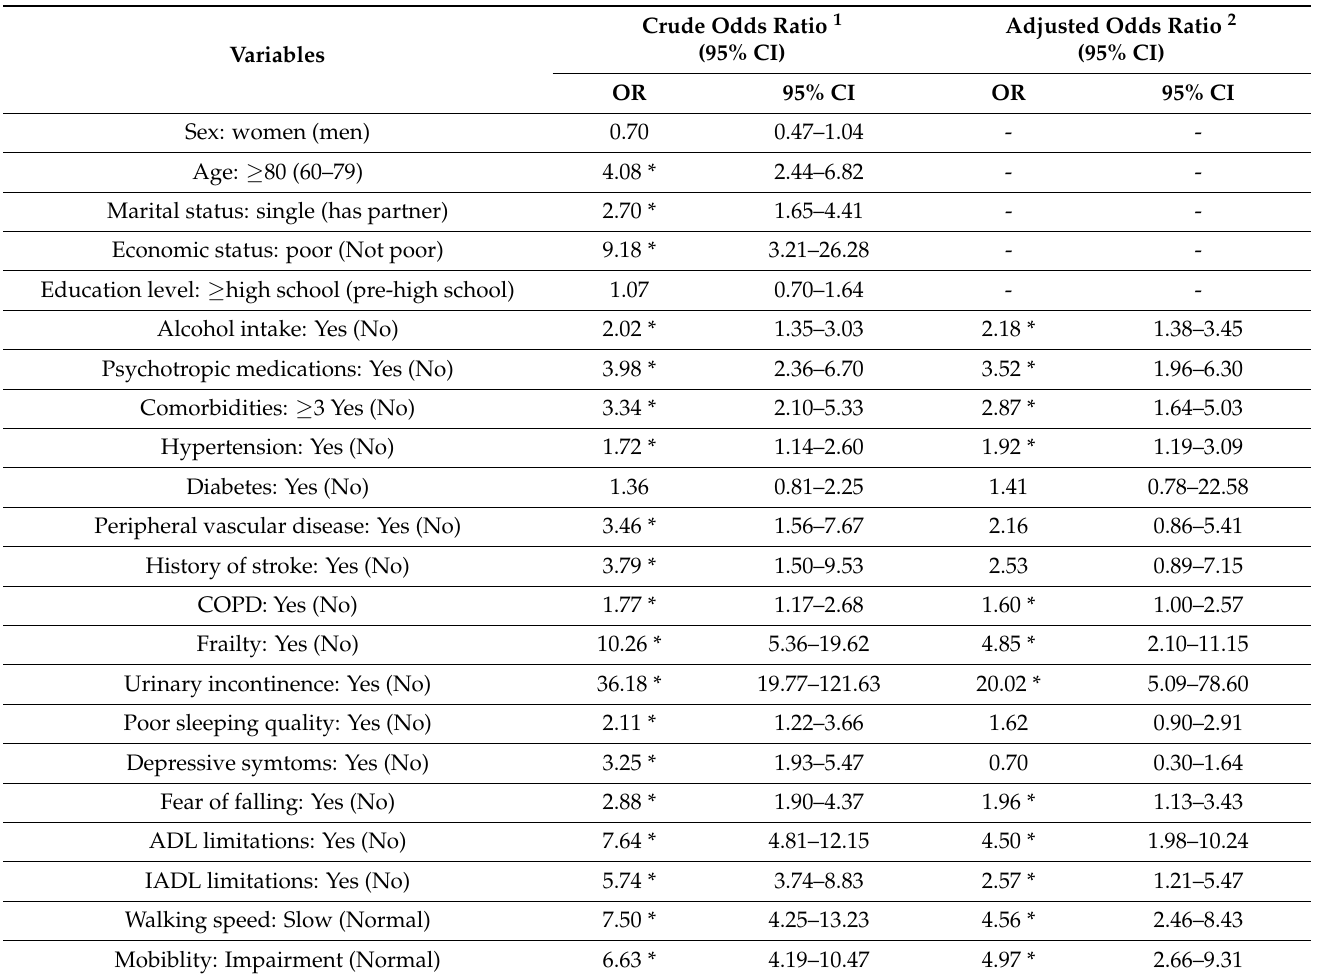
Table 3. Factors associated with fall from the univariate and multiple logistic